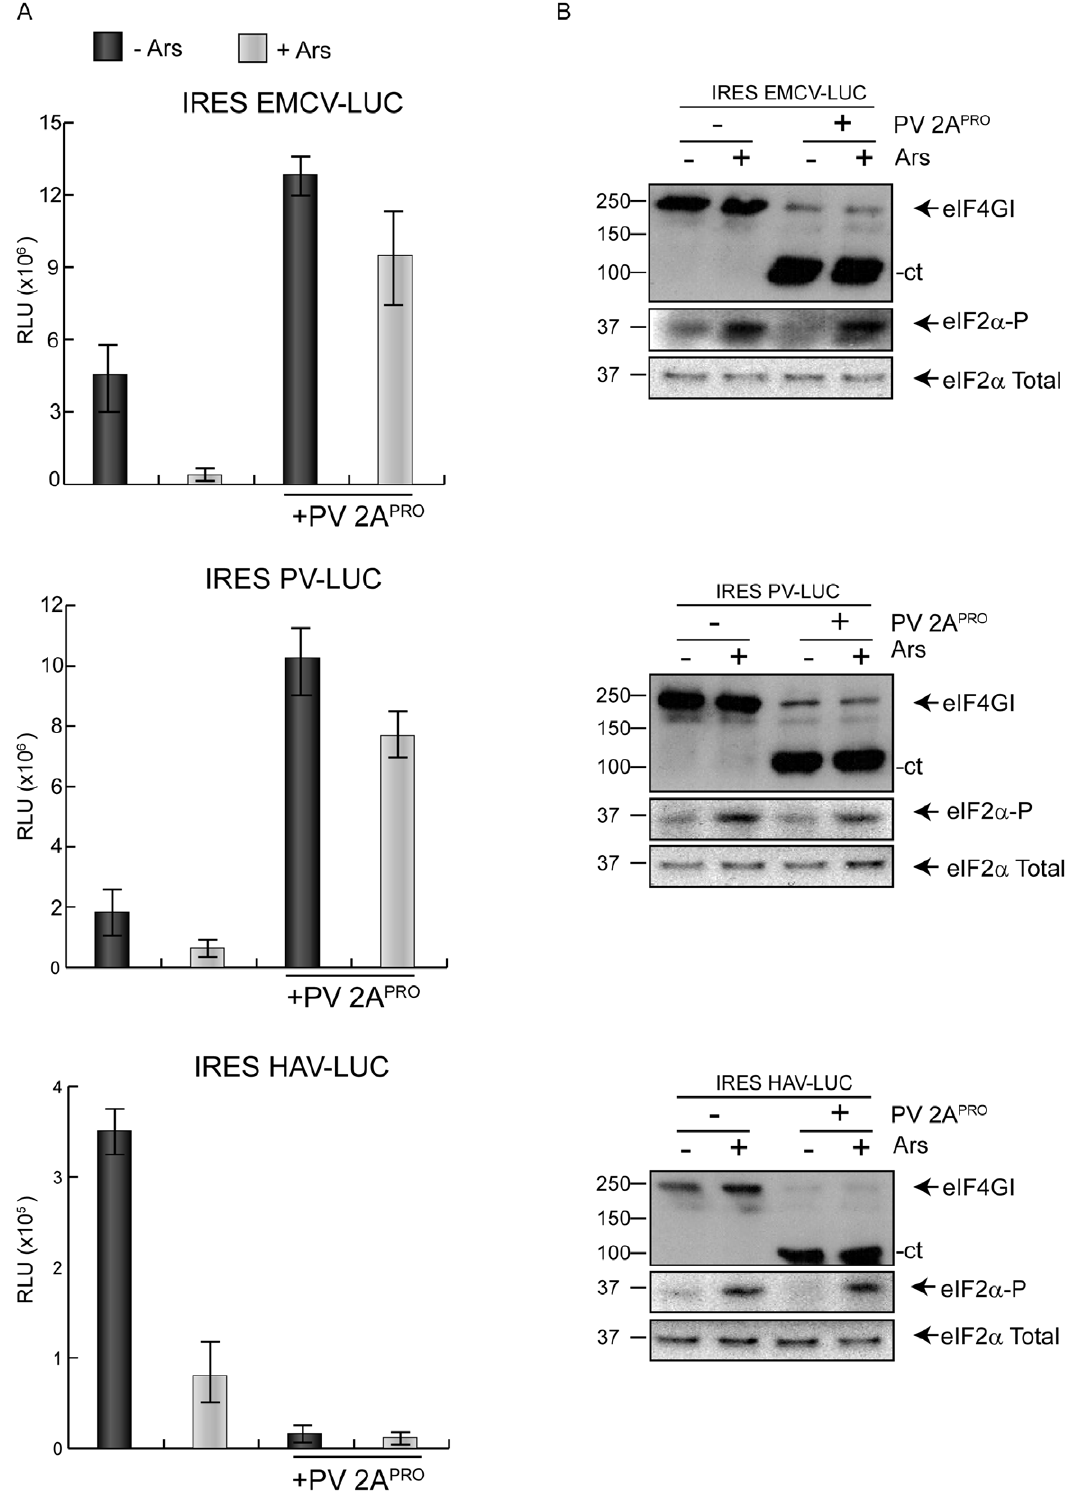
Figure 3. Inhibition of translation directed by PV or EMCV IRES by Ars. Rescue by PV 2A pro . A) BHKT7 cells were transfected with plasmids containing EMCV IRES-luc, PV IRES-luc or HAV IRES-luc alone or co-transfected with pTM1-2A. At 2 hpt cells were treated or not with Ars for 1 hour. Then, cells were harvested and lysated in luciferase buffer and luc activity was measured (as described in Materials and Methods) and represented from at least three independent experiments. Error bars indicate standard deviation (SD). B) eIF4GI, eIF2 a and phosphorylated eIF2 a were detected by western blot.